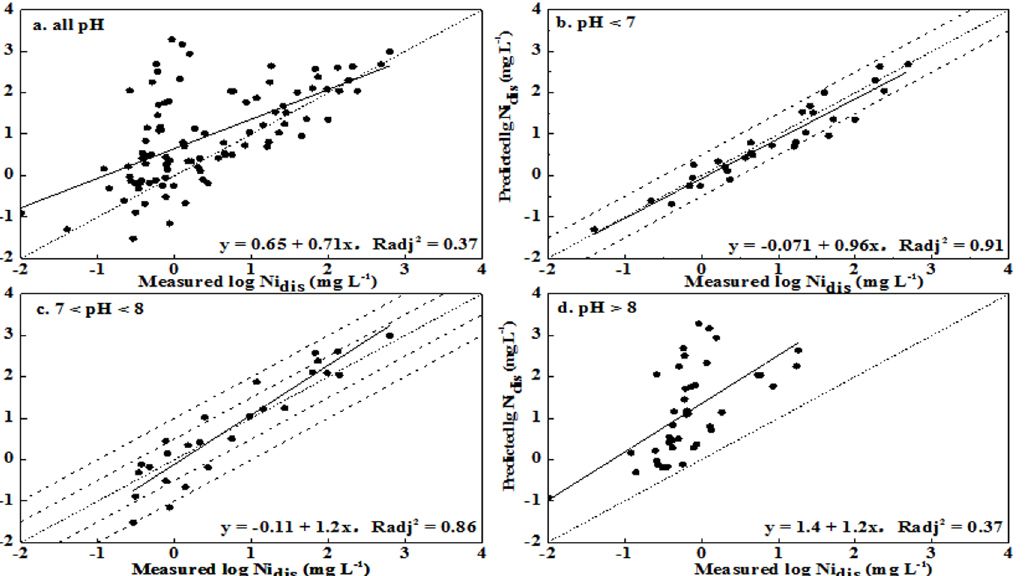
Fig 2. Measured soluble Ni concentrations versus predicted Ni concentrations using WHAM VI for leached soils (Ni dis represented the soluble Ni concentration in soil pore water).